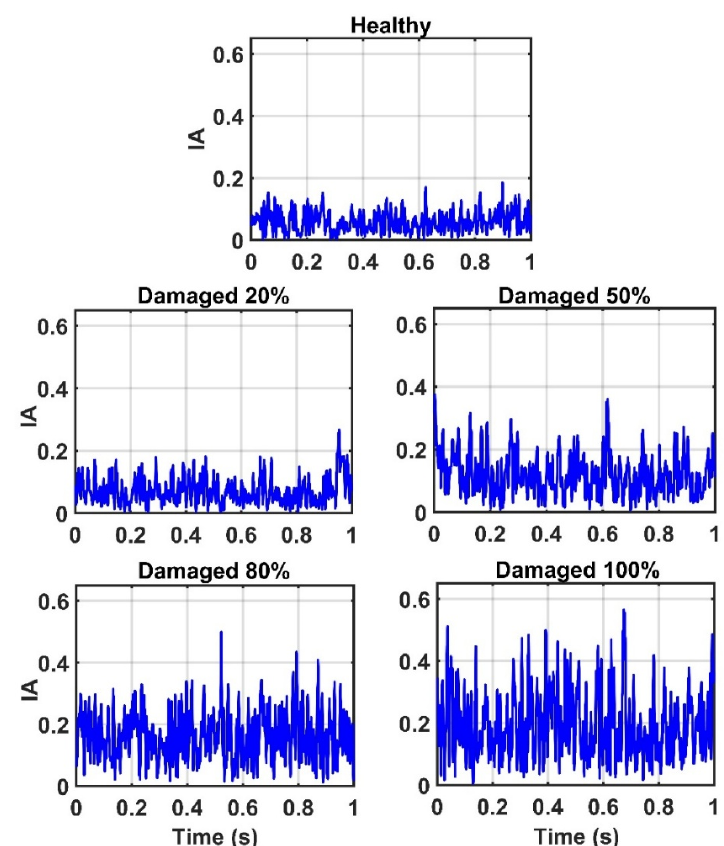
Figure 10. The estimated instantaneous amplitude (IA) of the sensor-10 by the proposed model for the healthy state and different damage levels of the truss.